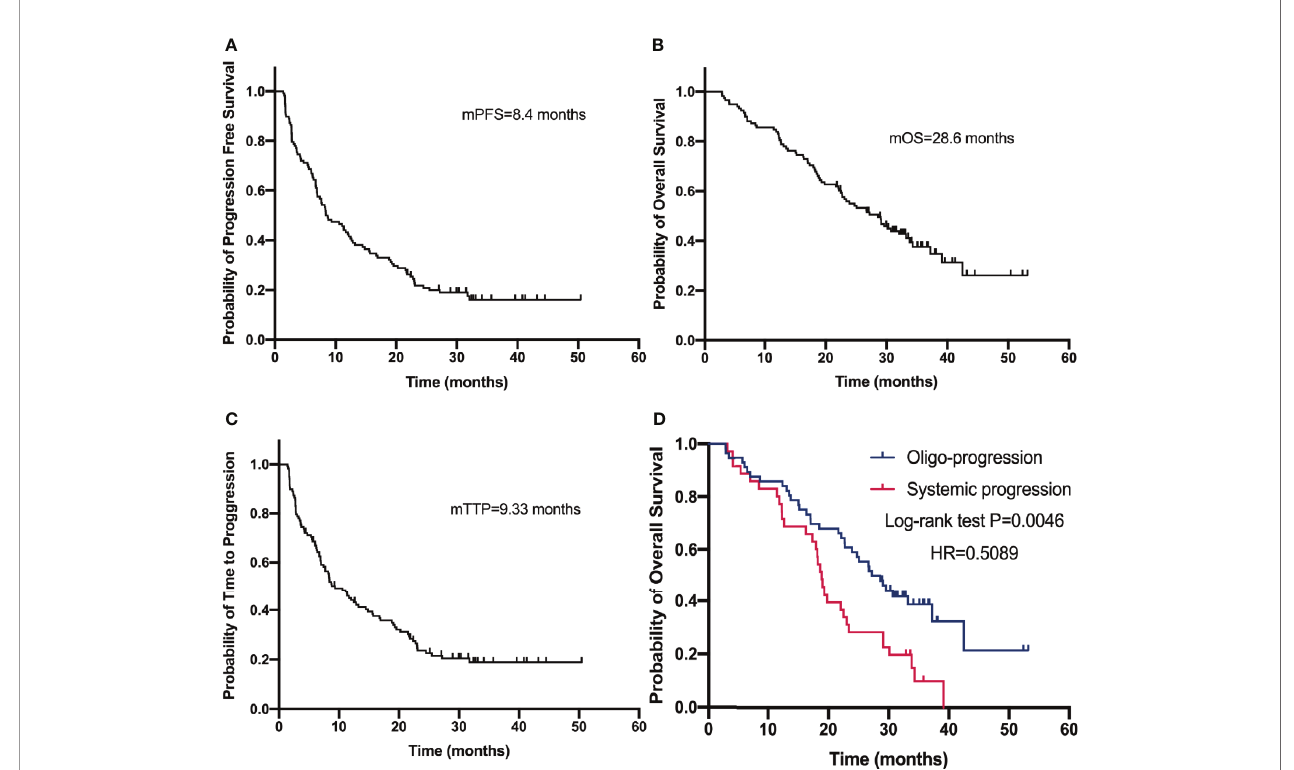
FIGURE 1 | Progression-free survival (A) , overall survival (B) , and time to progression (C) curves of 118 patients. Overall survival (D) of oligo-progression patients and systemic progression patients.